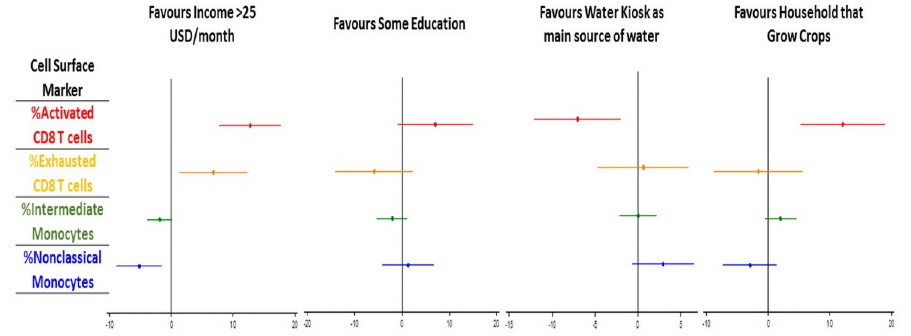
Fig 2. Adjusted fold change in cell surface immune activation markers according to socio-economic risk factors. Models for the effect of socio-economic variables on CD8 T cell and monocyte phenotypes, adjusted for age and sex, are shown. The x axis shows fold change with 95% confidence intervals for the following socio-economic comparisons: i) Income > 25 USD per month compared to income < / = 25USD/month ii) some education compared to no